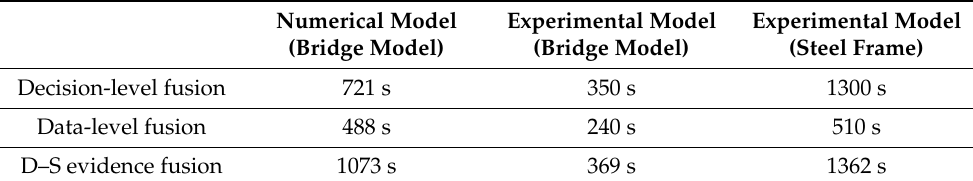
Table 9. Comparisons of the computational efficiency with the three fusion